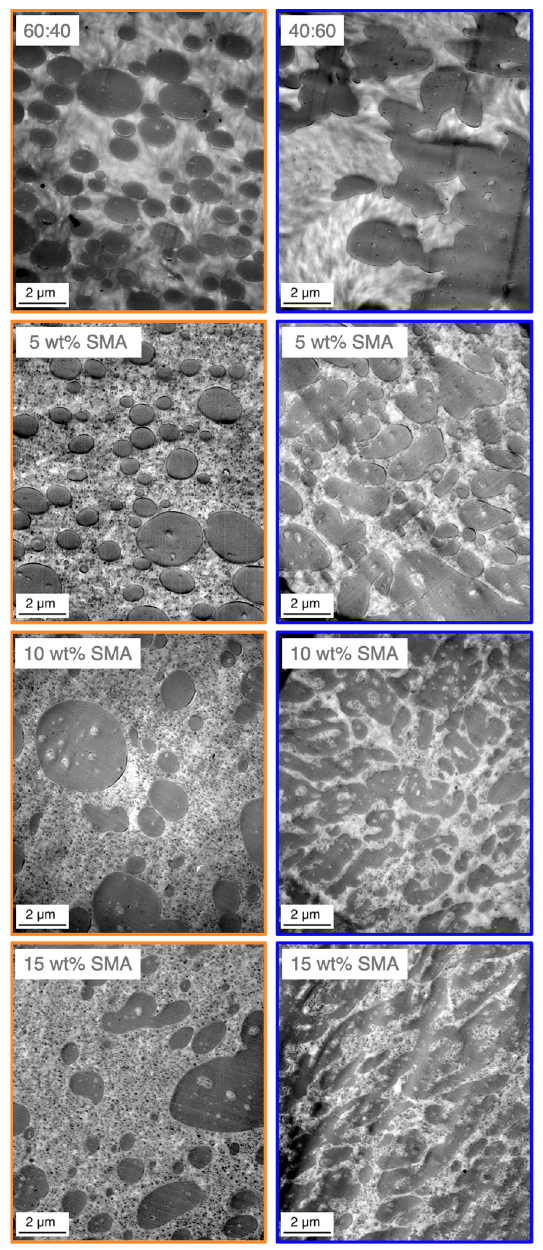
Figure 4. Transmission electron microscopy (TEM) micrographs of SMA compatibilized PA66 / PPE ternary blends, for 60 / 40 (left column) and 40 / 60 (right column) blend ratio with 0, 5, 10 and 15 wt% SMA.